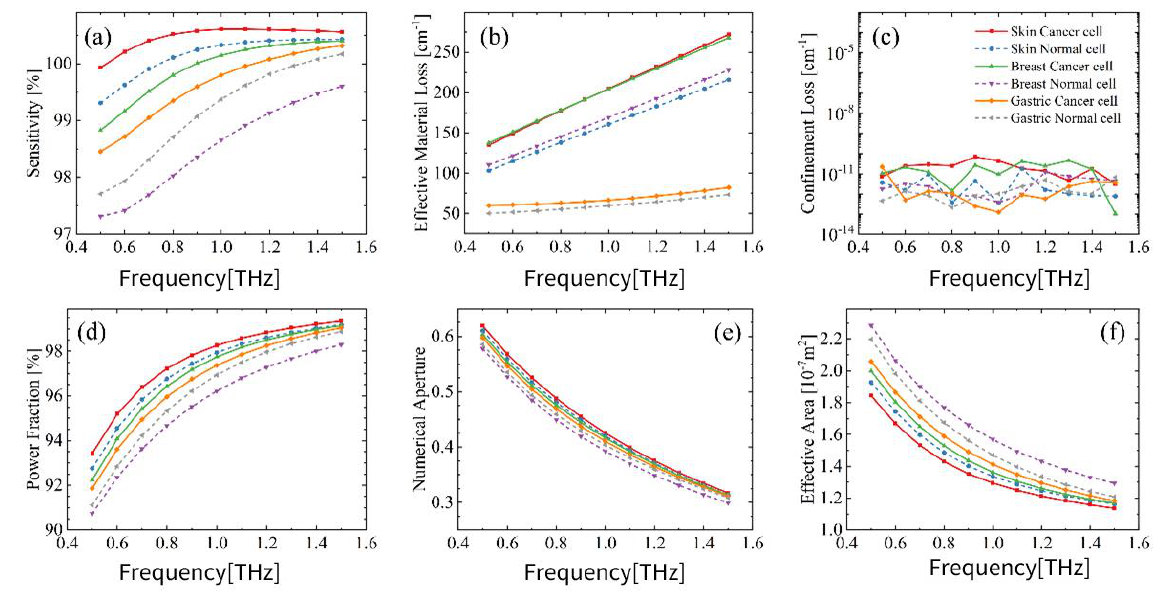
Figure 7. Comparison of parameters corresponding to different cancer cells with their corresponding normal cells under optimal design conditions. ( a ) Relative sensitivity, ( b ) EML , ( c ) CL , ( d ) power fraction, ( e ) NA , and ( f ) A eff with respect to frequency.